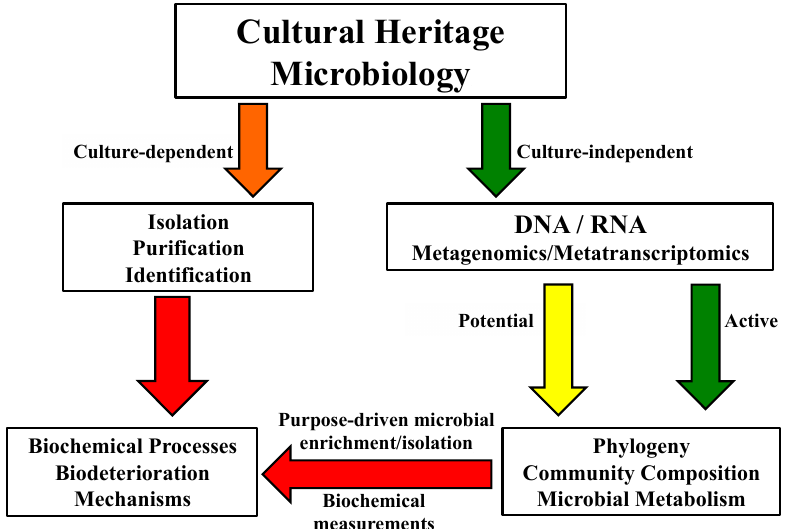
Figure 4. A schematic diagram showing the general framework in microbiological analyses of cultural properties and protection.